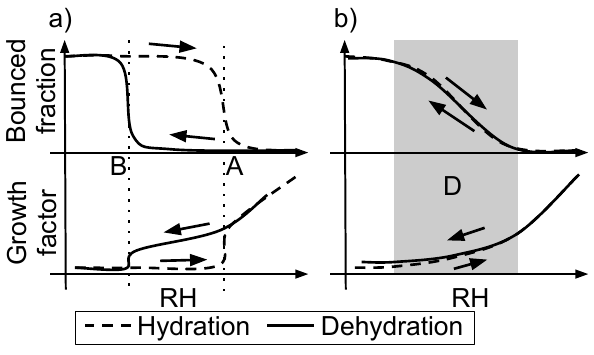
Fig. 3. A schematic figure of the relation of the fraction of the bounced particles and growth factor during hydration and dehydra- tion of, (a) a crystalline solid sample and (b) an amorphous solid sample. Growth factor curve schematics adapted from Mikhailov et al.